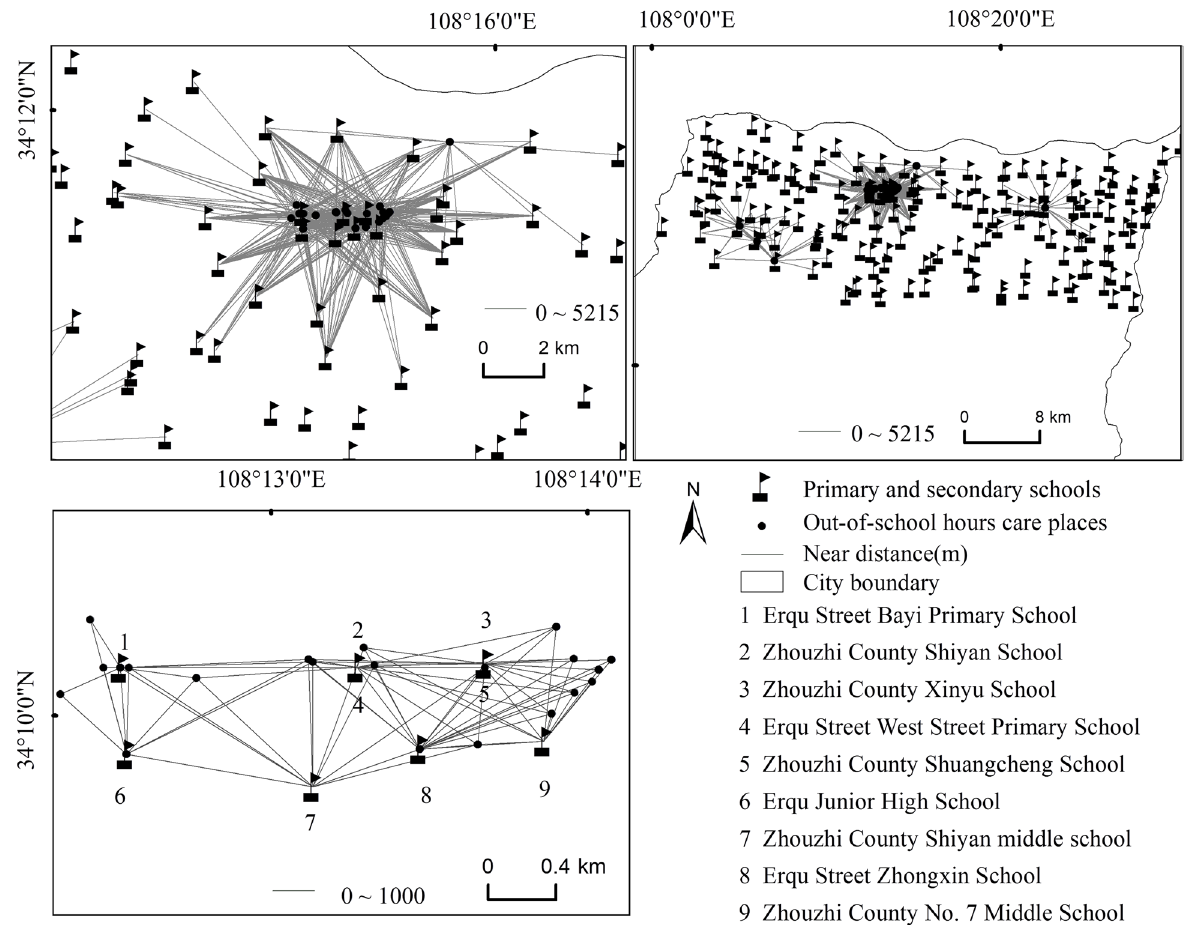
Fig. 4 OD analysis map of Zhouzhi County, Xi’an